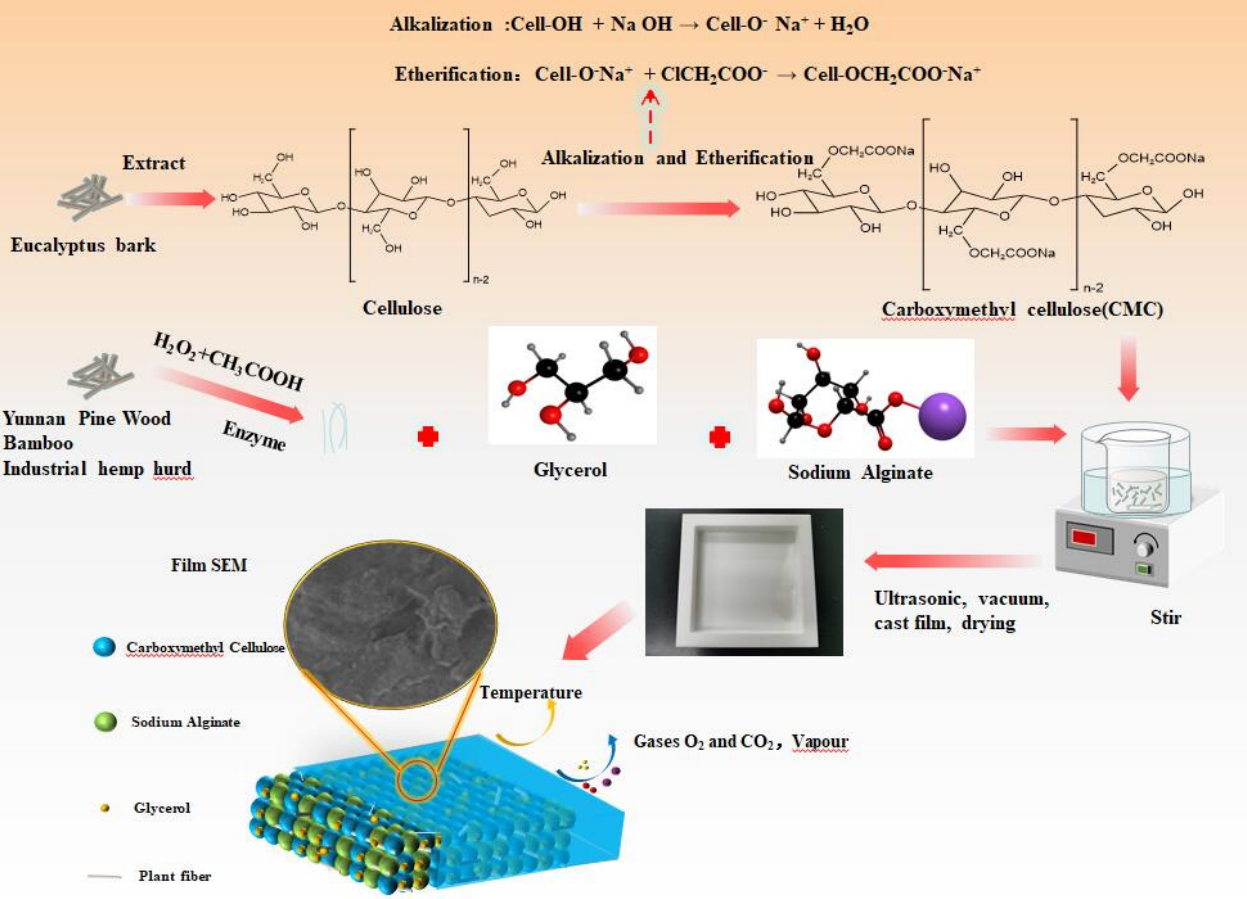
Figure 1. Preparation of CMC composite films.